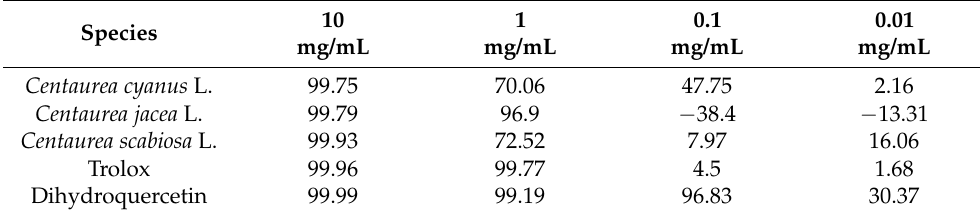
Centaurea scabiosa